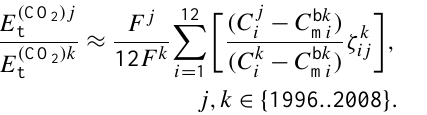
Fig. 3. The provinces of China taken into account in the analysis of the spatial distribution of emission changes for different threshold levels, [ NO 2 ] c , of the (depicted in the plots) annual mean measured tropospheric NO 2 column amounts for year 2008: (a) [ NO 2 ] c =